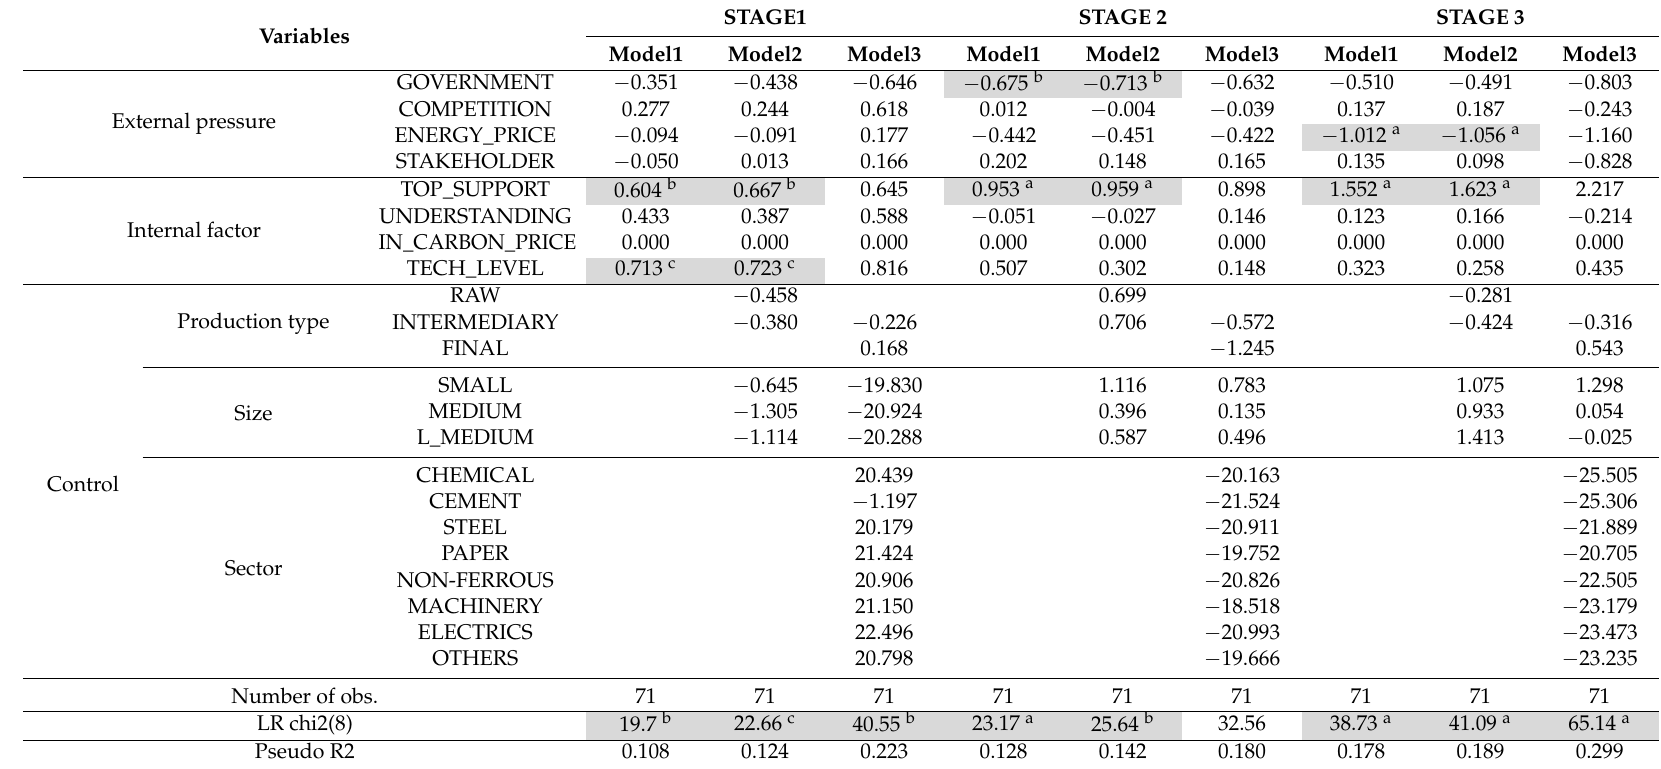
Table 8. Regression result with carbon management of STAGE 1 to